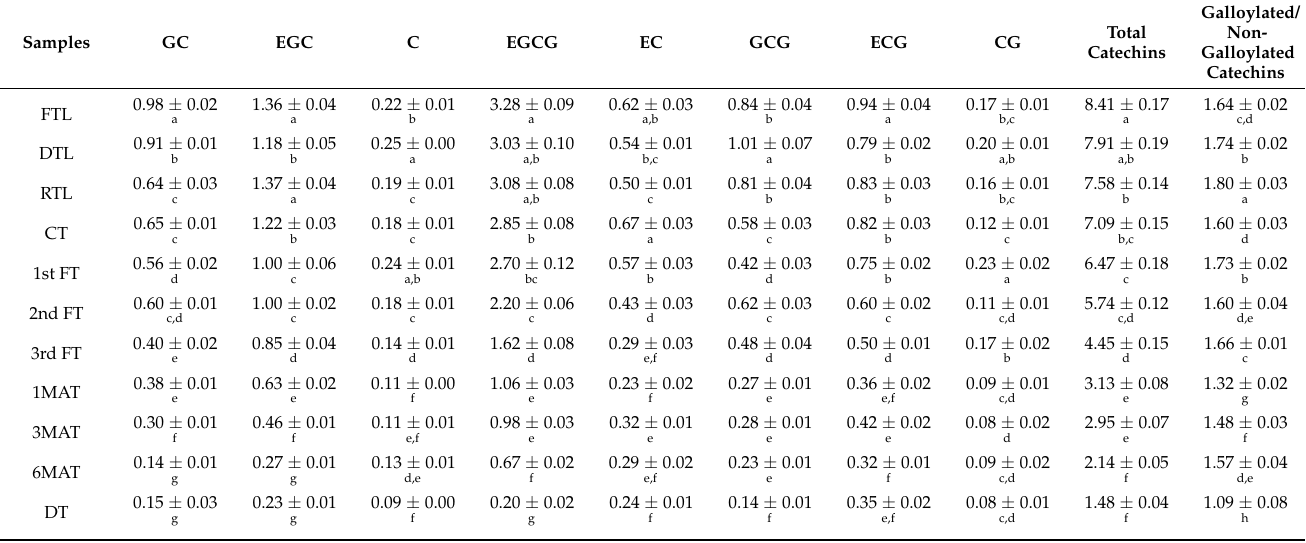
Table 2. The contents of catechins in QZT samples from different processing stages (% wt/wt ).